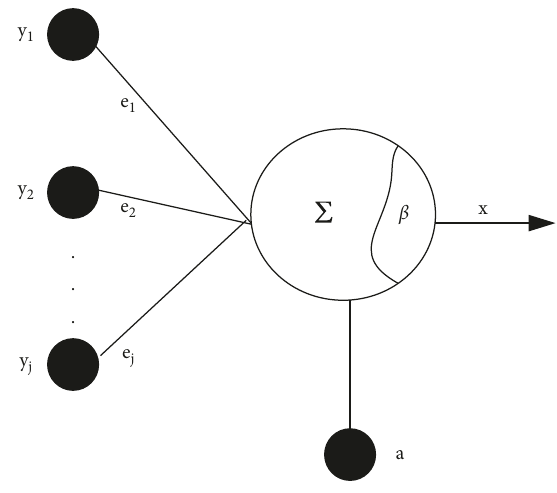
Figure 1: Perceptron cell